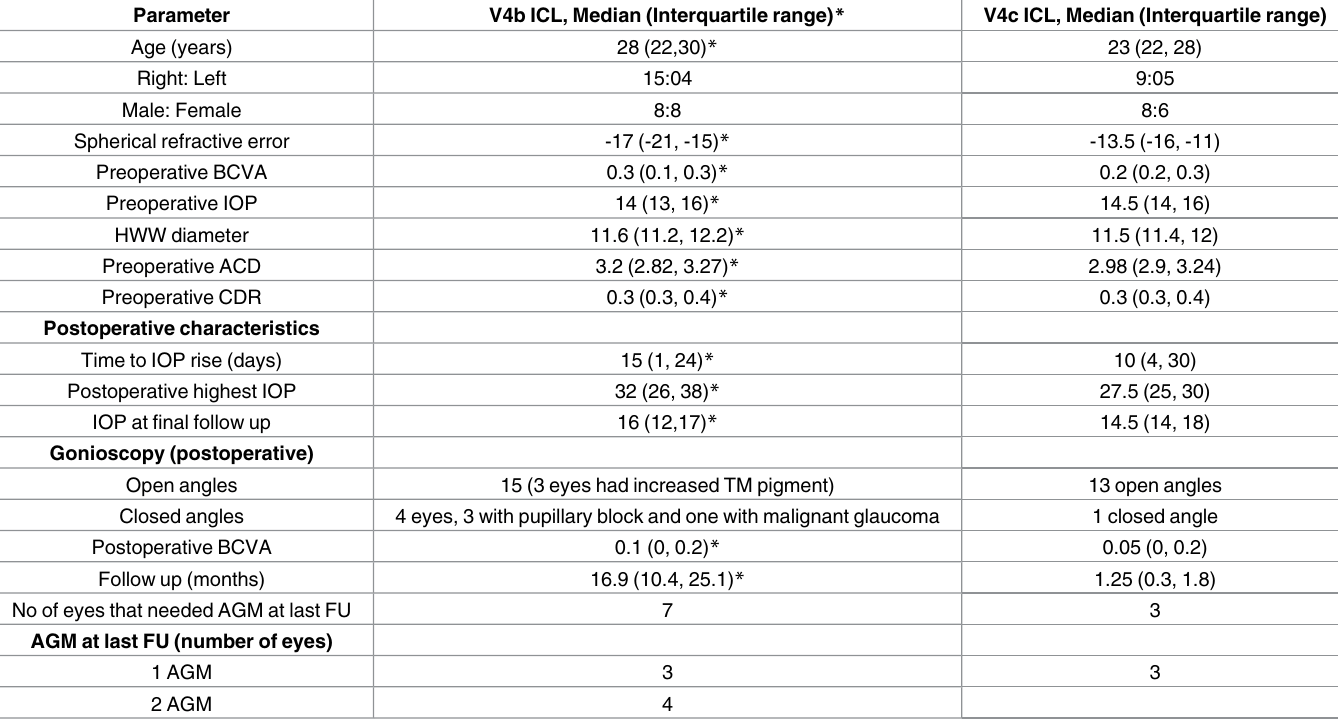
Table 1. Demographics and preoperative characteristics of subjects with raised IOP following V4 b (n = 19) and V4c ICL (n = 14) implantation.